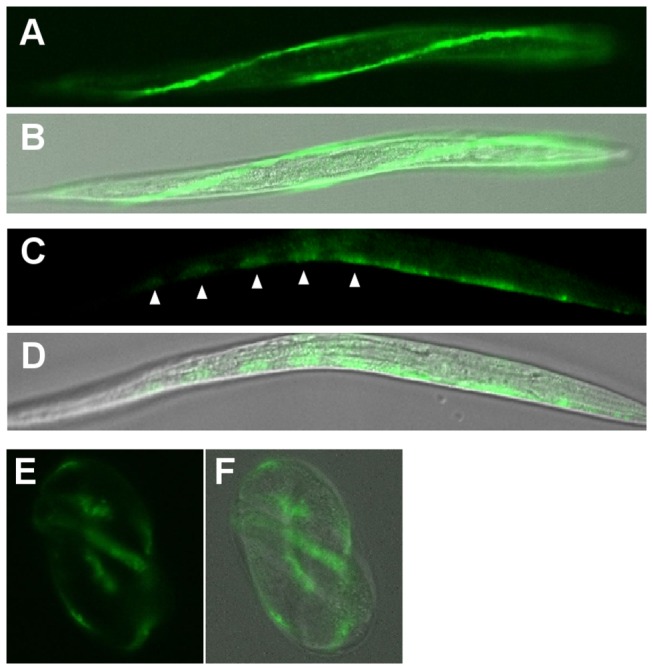
Cellular localizations of R09B5.11 in C. elegans.The R09B5.11::egfp fusion construct under the control of the R09B5.11 promoter was injected into C. elegans, and the expression of the R09B5.11::eGFP fusion protein was visualized with a confocal laser microscope. GFP images and merged pictures of GFP with DIC images in the L2 stage (A–D) or three-fold embryo (E and F) are shown. Left- and right-lateral strings of seam cells (A and B) and individual seam cells (C and D) are visualized. Arrowheads indicate each seam cell.